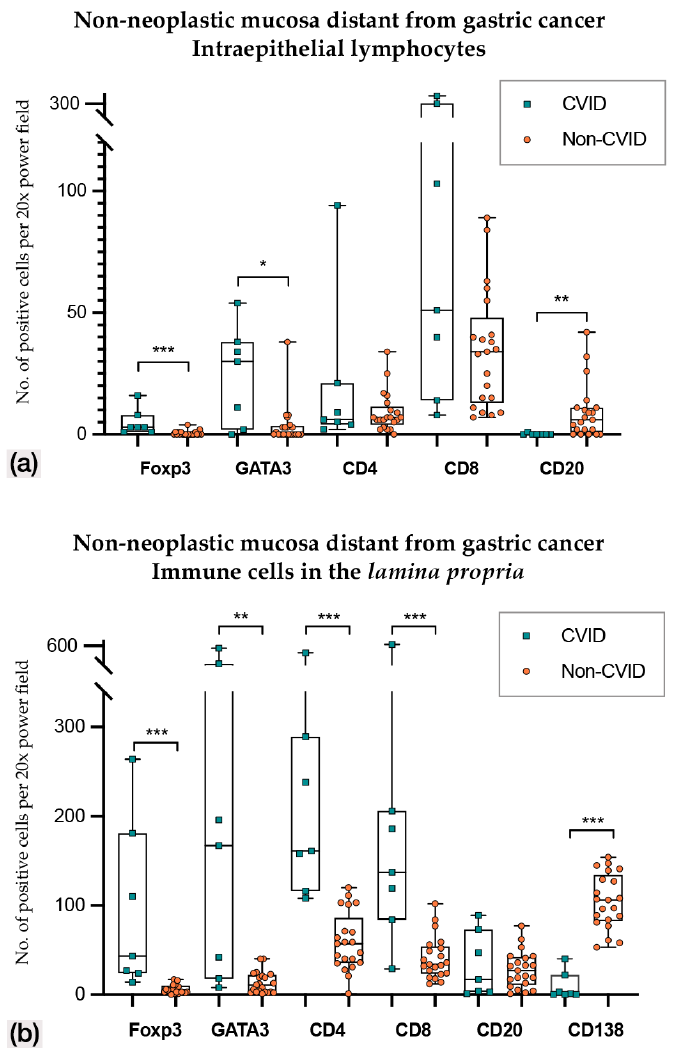
Figure 3. ( a ) Intraepithelial lymphocyte counts in non-neoplastic mucosa distant from gastric cancer in CVID and non-CVID patients; ( b ) counts of immune cells in the lamina propria in non-neoplastic mucosa distant from gastric cancer in CVID and non-CVID patients. Statistically significant results are highlighted by asterisks: * p ≤ 0.05; ** p ≤ 0.01; *** p ≤ 0.001.